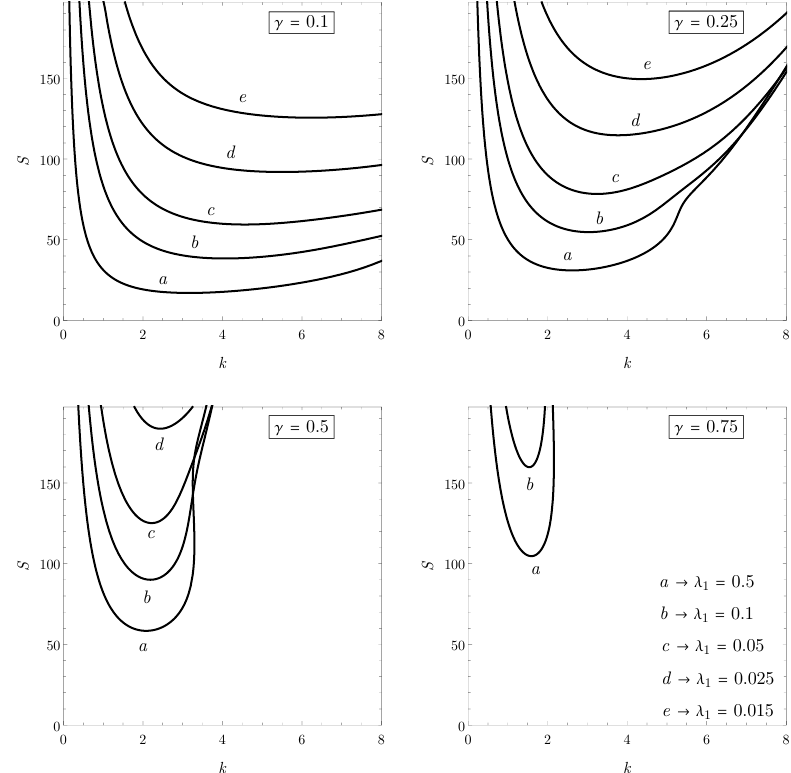
Figure 3. Neutral stability curves ( k , S ) for different values of γ and λ 1